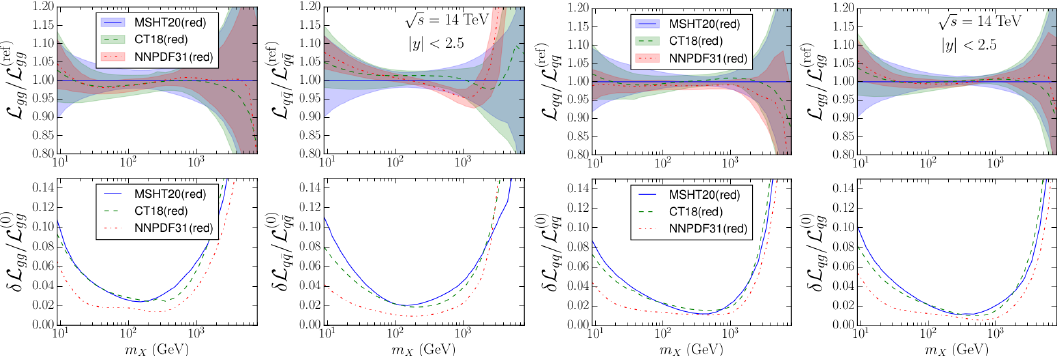
Figure 4: Comparison of the luminosities of the 3 reduced fits for gluon-gluon, quark- antiquark, quark-quark and quark-gluon (going from left to right). The absolute luminosities relative to that of the MSHT reduced fit are shown in the upper plots, whilst the uncertainties in the luminosities are shown in the lower plots. A rapidity cut of | y | < 2.5 is applied for the